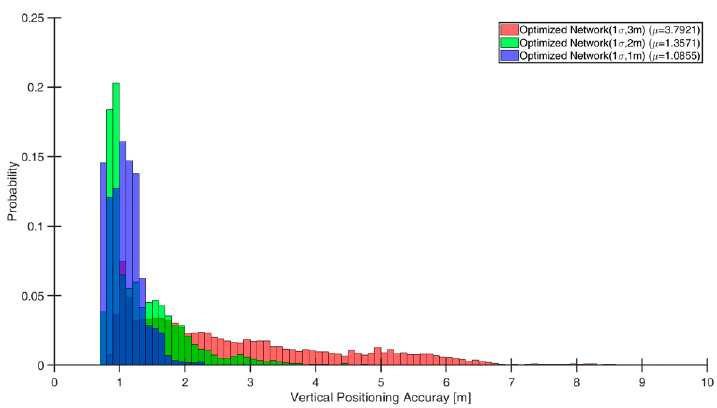
Figure 7. Vertical positioning accuracy distributions in the flight space using the three optimized LTE/DRSC networks. LTE / DRSC